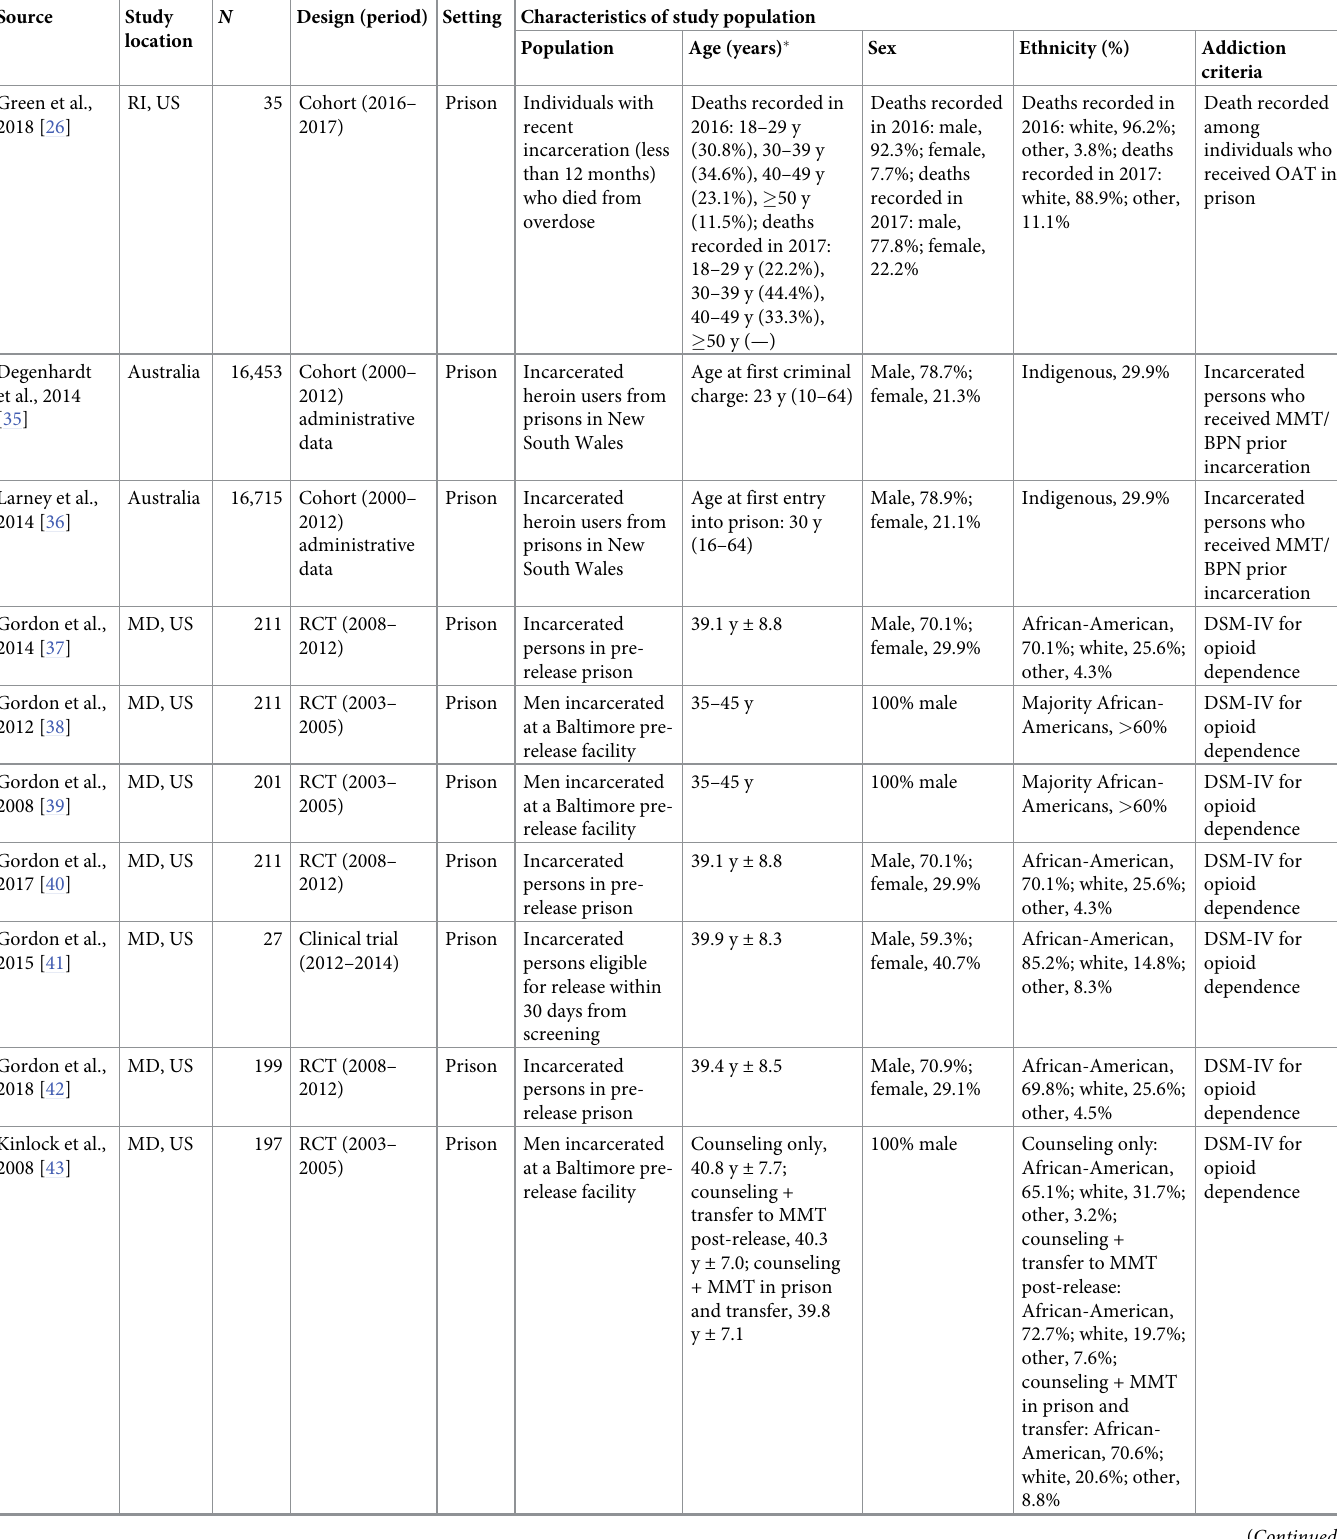
Table 1. Characteristics of included studies,